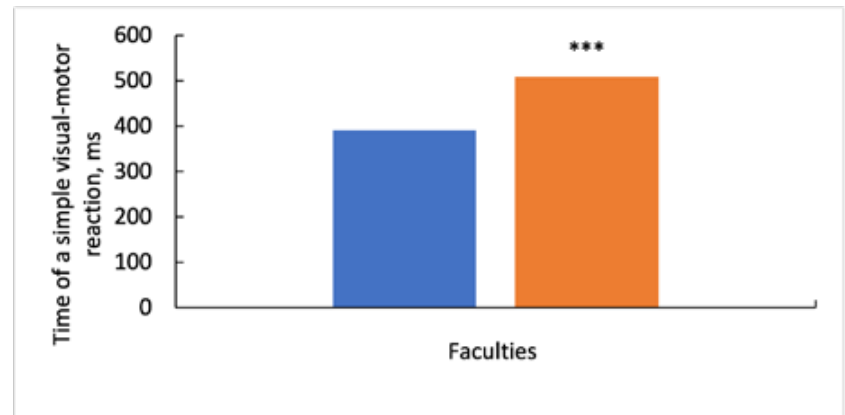
Figure 1. The value of the time of a simple visual-motor reaction in students of the Faculty of Arts in comparison with students of other